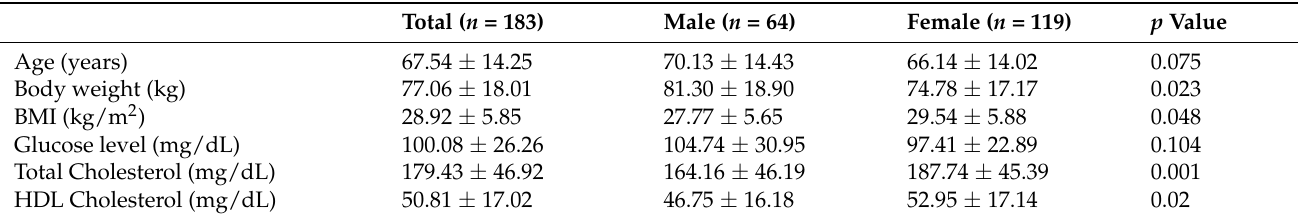
Table 1. Main characteristics of the study